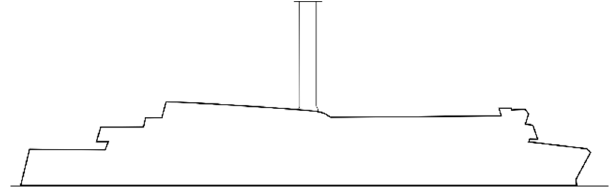
Figure 1. Sketch of the example ferry with one Flettner rotor.